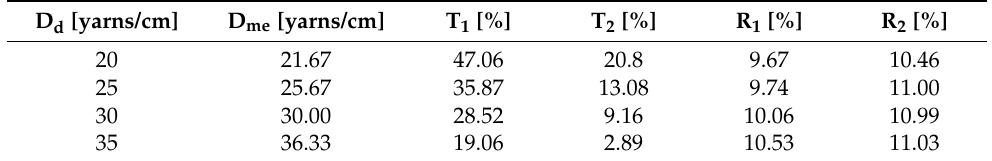
Table 3. D d and D me values of the transmission T (%) and reflection R (%), for single- (T 1 , R 1 ) and double- (T 2 , R 2 ) layered CO samples.